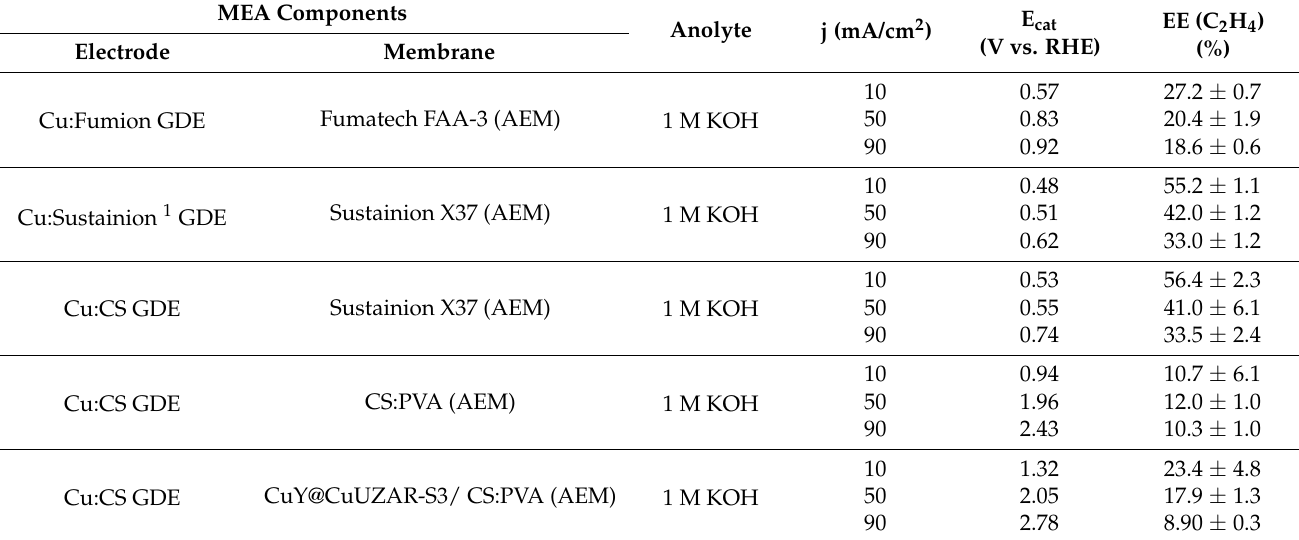
Table 2. Experimental results of the CO 2 R conversion to C 2 H 4 in MEA configuration with Cu-based gas diffusion electrodes in 1 M